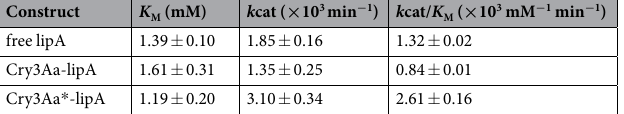
Table 3. Kinetic parameters of lipA constructs. The values for K M and k cat were derived from the corresponding Lineweaver–Burke plots. Experiments were performed in triplicate, and the averages are shown with the standard deviation of the